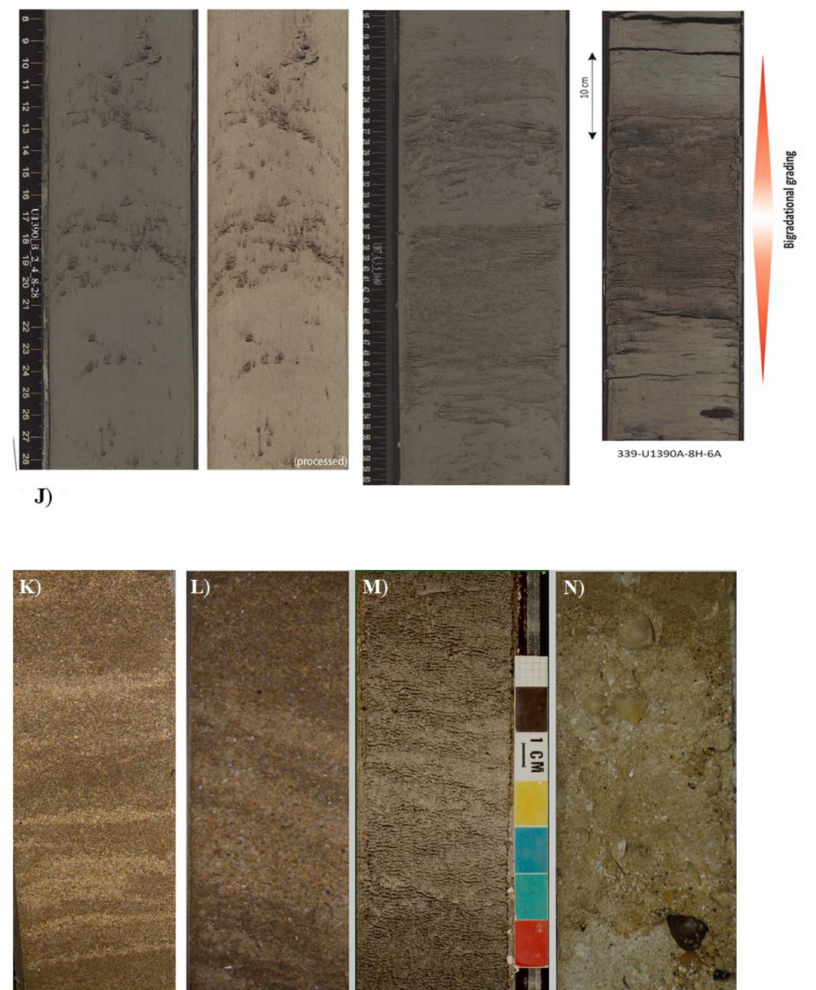
Figure 15. Contourite family: photographic examples of modern contourites, core sections. Locality: ( A – H ) and ( J–M ) are from the Gulf of Cadiz, N Atlantic while ( I , N ) are from the Hebridean margin, NE Atlantic. ( A – G ) from [105]. ( A ) Muddy contourite, bioturbated. ( B ) Silty mud contourite, bioturbated and with thin silt lenses. ( C ) Muddy silt contourite, bioturbated and with thin silt lenses. ( D ) Muddy sand contourite, bioturbated and with irregular lenses. ( E ) Muddy fine sand contourite, with parallel lamination. ( F ) Muddy fine sand contourite, structureless. ( G ) Medium to coarse-grained sand collected as grab sample from seafloor contourite. ( H ) Part of bi-gradational contourite sequence (divisions as shown). ( I ) Muddy and silty contourites. ( J ) Core sections from contourite depositional system drilled during the Integrated Ocean Drilling Program (IODP) Expedition 339, showing muddy and silty contourites with indistinct lamination, and complete bi-gradational contourite sequence (right). ( K – L ) Sandy contourites, with parallel and cross-bedding. ( M ) Sandy contourite, structureless and muddy, Campos slope, o ff shore Brazil. ( N ) Pebbly sand contourite, Barra contourite sand